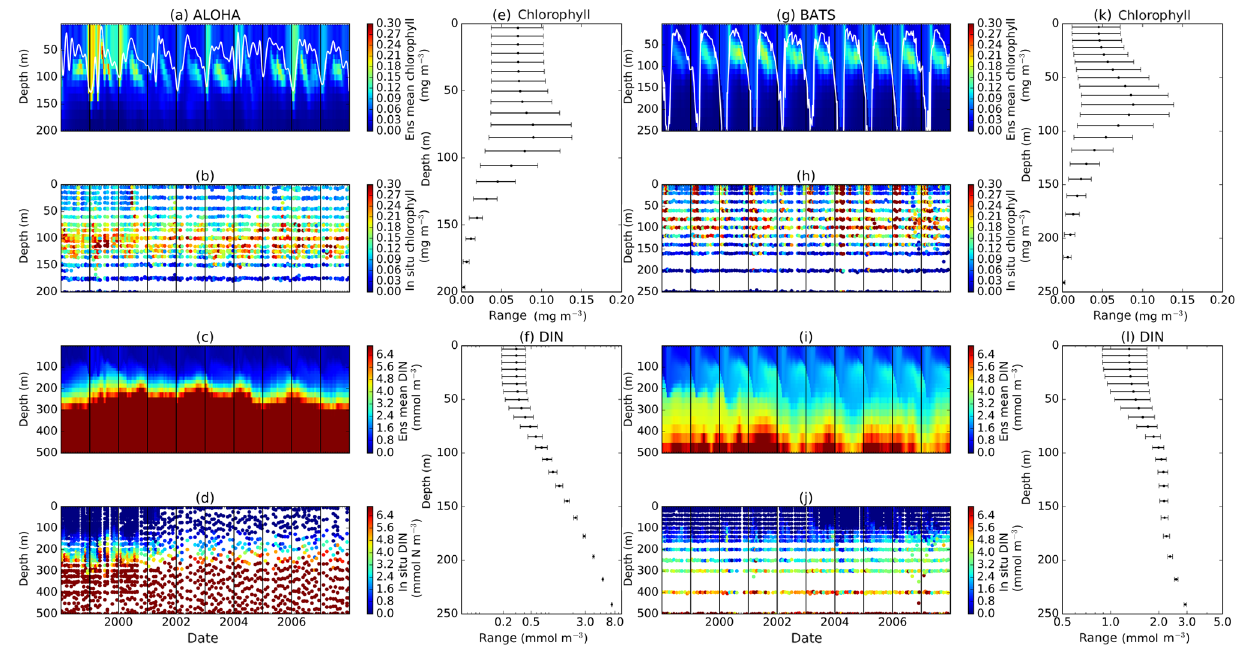
Figure 9. Time series (from January 1998 to December 2007) of ensemble mean and in situ concentrations, and range of chlorophyll and DIN at oligotrophic stations. Station ALOHA is shown in (a) – (f) and BATS is shown in (g) – (l) . The white solid line in (a) and (g) represents mixed layer depth. (e) , (f) , (k) , and (l) are the 75th and 25th percentile range of chlorophyll ( e for ALOHA and k for BATS) and DIN ( f for ALOHA and l BATS) over the depth. The range is obtained by averaging the chlorophyll and DIN concentrations of each ensemble member over the time series at each depth. The black dots in (e) , (f) , (k) , and (l) are the mean of the ensemble. Ensemble mean chlorophyll profiles (shown in a and g ) and DIN ( c and l ) are obtained from all of the ensemble members. In situ chlorophyll is shown in (b) and (h) , and DIN is shown in (d) and (j) , for ALOHA and BATS respectively.